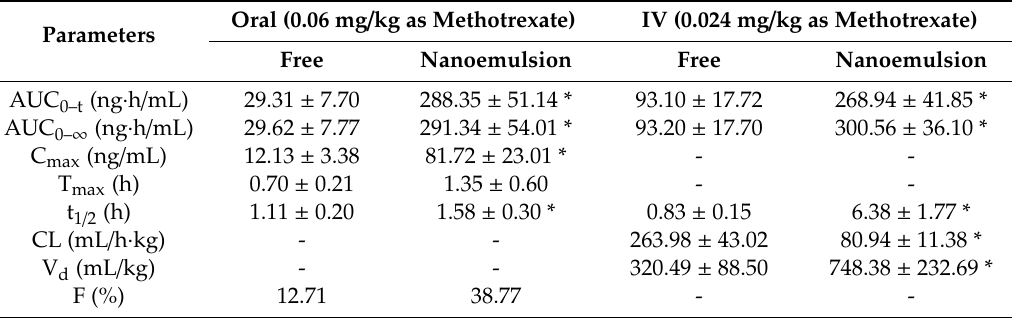
* p < 0.05 between free methotrexate and nanoemulsion groups.